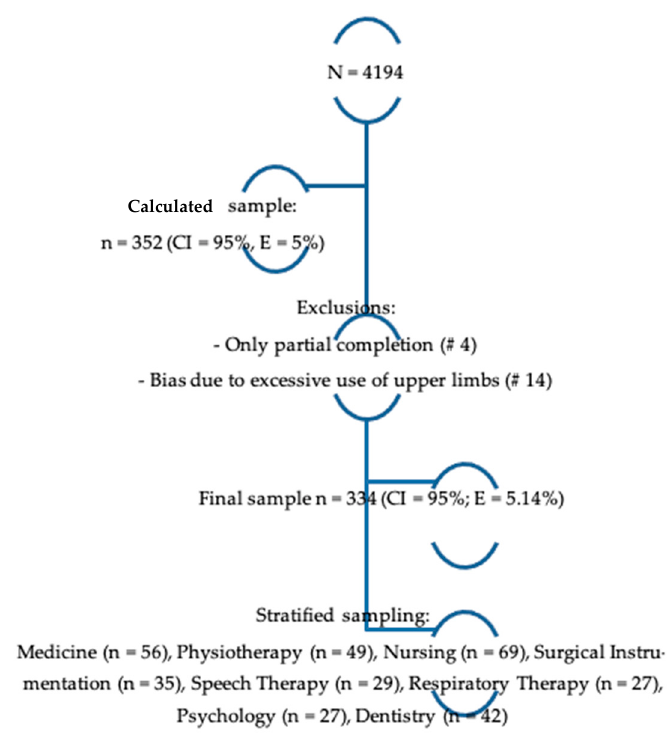
Figure 1. Flowchart of study participants.